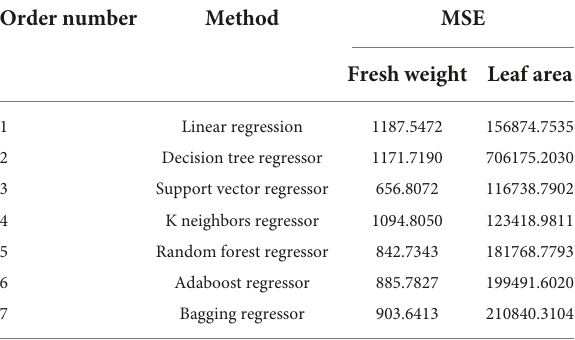
TABLE 9 The MSE results of different machine learning algorithms in the third